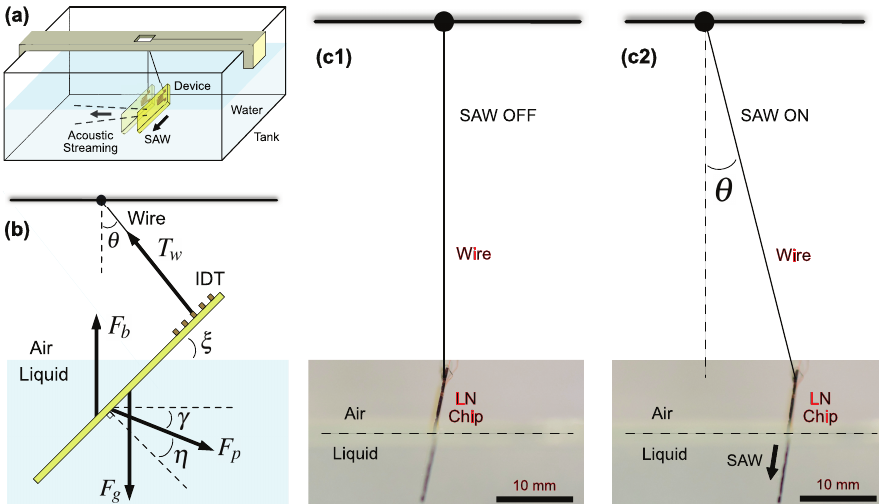
Figure 1. The pendulum force balancing method for measuring SAW propulsion forces via acoustic streaming, illustrated in ( a ), with the overview of a glass tank filled with the immersion fluid. A SAW device is suspended as the bob of a pendulum from a 3D-printed fixture at the top using the wires to connect the IDT of the SAW device as the pendulum arm. Taking ( b ) into account the tilted configuration of the SAW device and the Rayleigh angle η of the acoustic wave propagating from it into the fluid as it swings to an angle θ , an appropriate force balance may be formed. Images taken from the side of the setup ( c ) of a SAW device (c1) before and (c2) after activating the SAW indicates its deflection angle θ as a pendulum. The edge of the LN chip is marked in black for